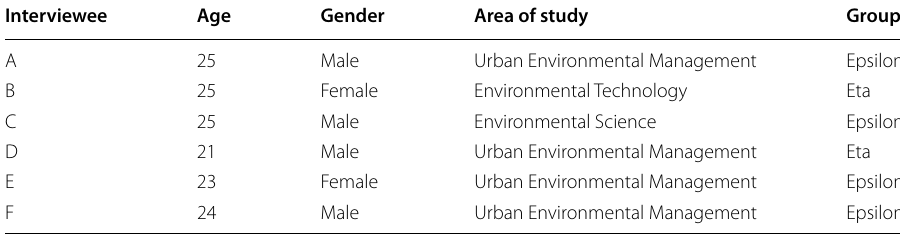
Table 1 List of interviewees with area of study, gender, and group identified Interviewee Age